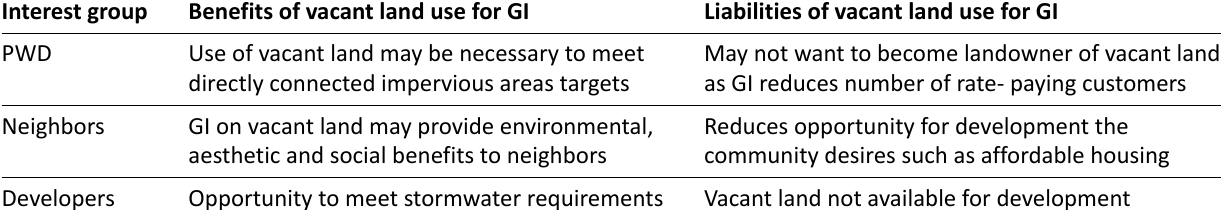
Table 5. Value of vacant land to different interest groups. Interest group